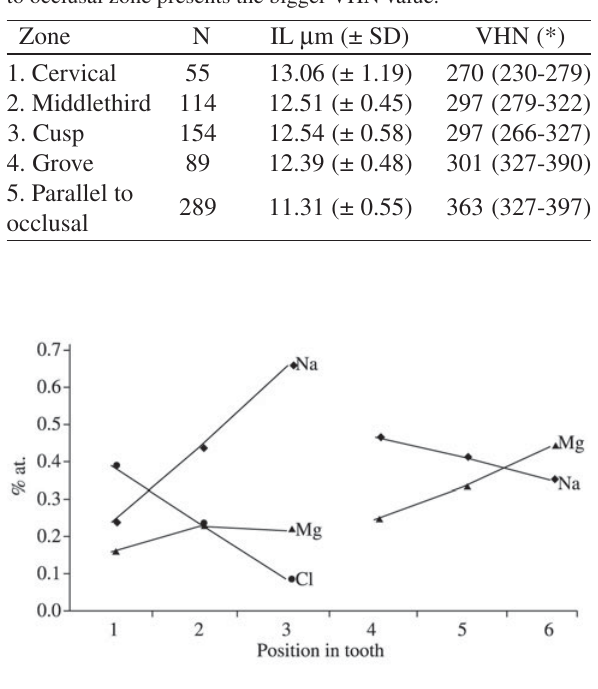
Table 2. Vicker’s hardness number (VHN) and indentation length (IL) for the five analyzed zones from the 7 samples analyzed. Mean values and standard deviation (SD) for IL and VHN are shown. N is the number of indentations taken from the 7 samples, and taken in account for statistics. These data was obtained with a load of 25 g. Note the small variations in VHN values for the first four zones when SD, indicated by (*), is taken in account. The parallel to occlusal zone presents the bigger VHN value.